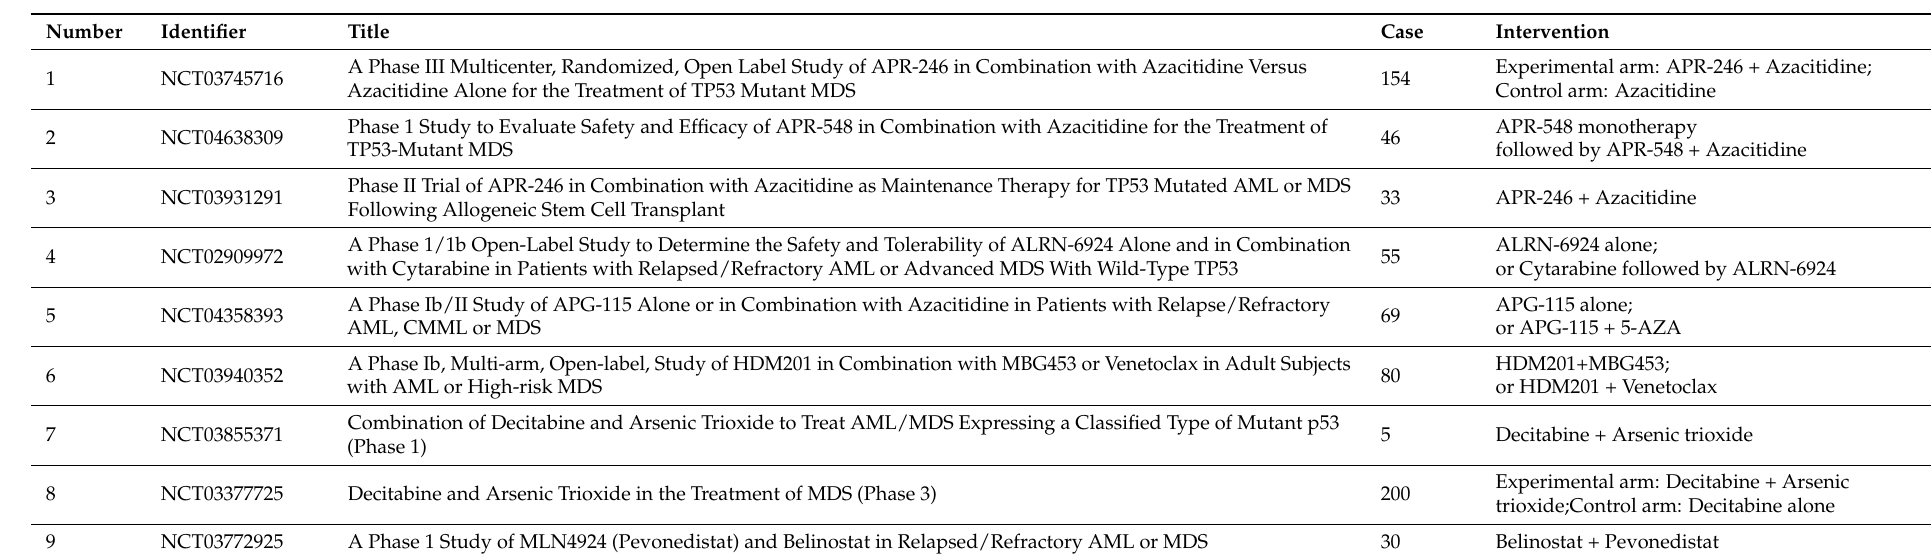
Table 2. The ongoing clinical trials in TP53 mutant